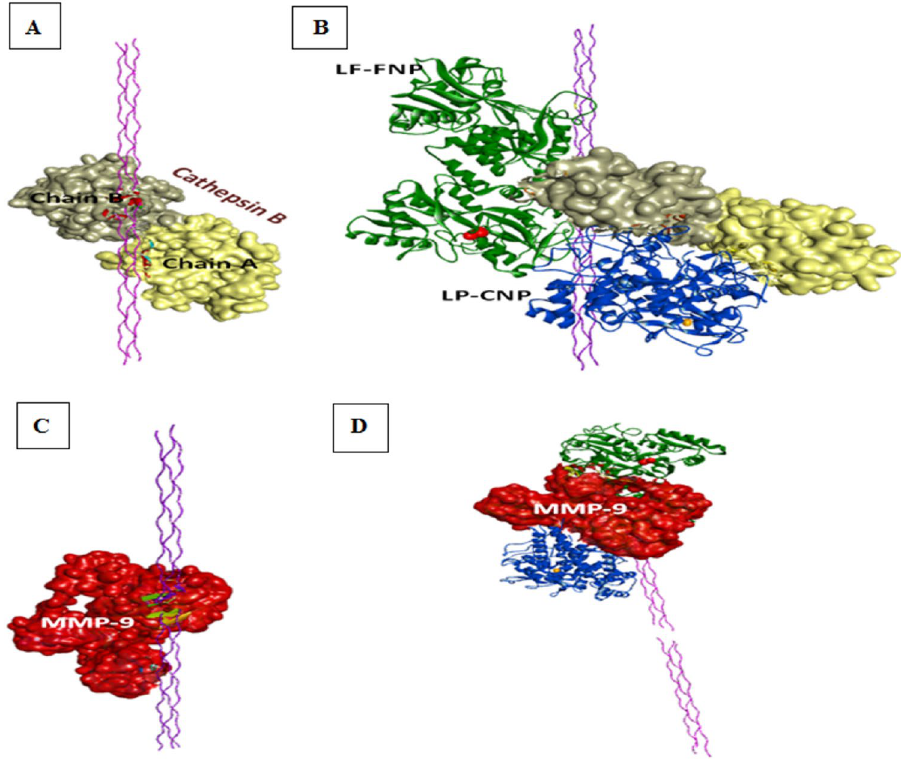
Figure 8. Proposed inhibitory effect of LP-CNPs and LF-FNPs combination on cathepsin B and matrix metalloproteinase (MMP)-9 activities. ( A ) Docking model of cathepsin B (PDB ID: 3AI8, chain A "yellow surface", chain B "gray surface") with collagen protein (triple helix model, PDB ID: 1K6F, purple). ( B ) Docking model of cathepsin B with LP-CNPs (blue cartoon, the orange space-filling spheres style refers to the interacting CuO) and LF-FNPs (green cartoon, the red space-filling sphere style refers to the interacting Fe 3 O 4 ), followed by the collagen protein. ( C ) The docked complex of MMP-9 (PDB ID: 1L6J, red surface) with collagen protein. ( D ) Docking model of MMP-9 with LP-CNPs (blue cartoon, the orange space-filling spheres style refers to the interacting CuO) and LF-FNPs (green cartoon, the red space-filling sphere style refers to the interacting Fe 3 O 4 ), followed by the collagen protein. The docked complexes of cathepsin B and MMP-9 with LP-CNPs and LF-FNPs were given by the PatchDock server (https:// bioin fo3d. cs. tau. ac. il/ Patch Dock/ php. php), while the docked complexes with collagen protein were obtained by the HDOOK server (http:// hdock. phys. hust. edu. cn/). All the provided docked complexes were visualized by by Discovery Studio 2020 Client software 20.1 (https:// www. 3ds. com/ produ cts- servi ces/ biovia/ produ cts/ molec ular- model ing- simul ation/ biovia- disco very-